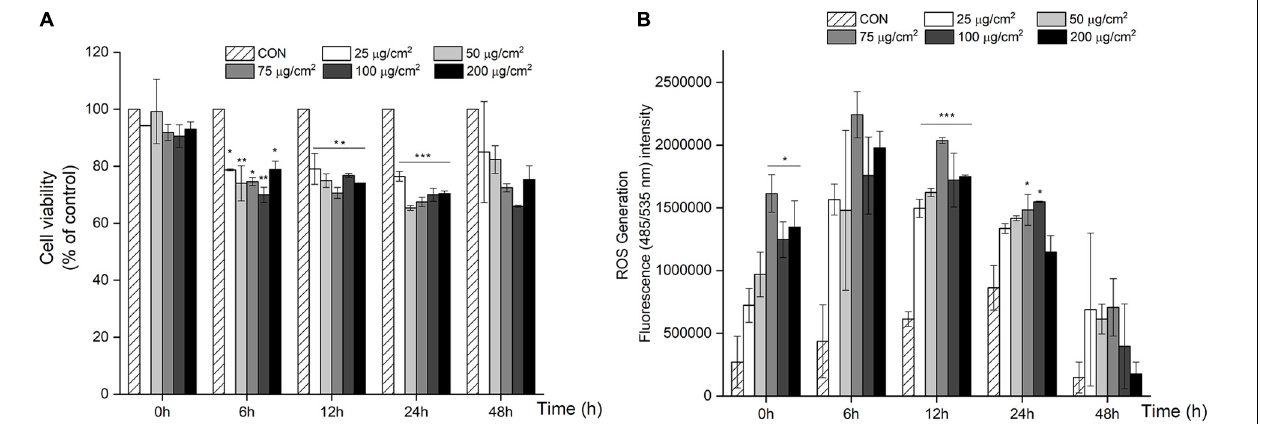
FIGURE 1 | PM-induced negative effects on cell viability and over-production of ROS in A549 cells. (A) Cell viability decreased in a dose and time dependent manner in A549 cells after 24 and 48 h of PM treatment. (B) ROS generation increased with PM treatment in A549 cells after 24 and 48 h of incubation. Values are the ratio and the means ± SEM. * P < 0.05, ** P < 0.01, and *** P < 0.001 compared with